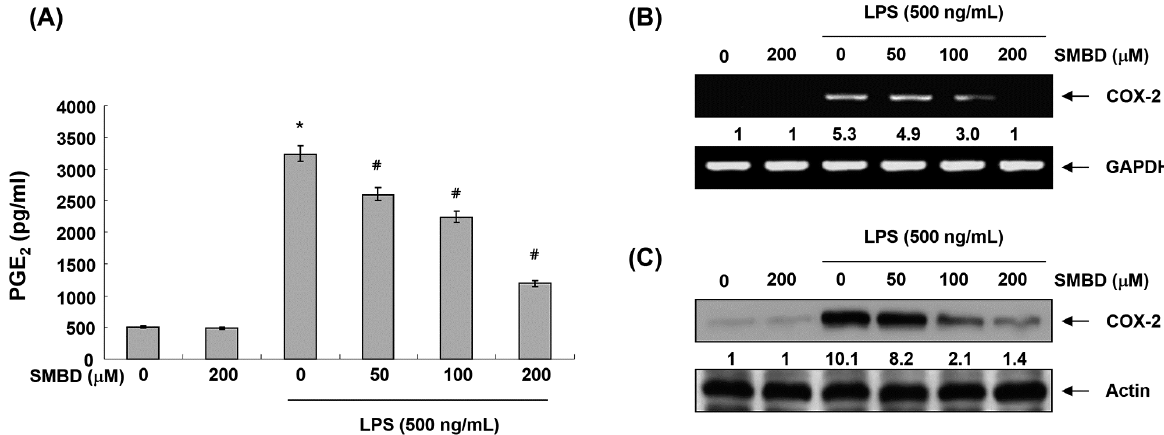
Figure 3. Effects of SMBD on LPS-induced PGE 2 production and COX-2 expression in BV2 microglia. Cells were treated with the indicated concentrations of SMBD for 1 h and then incubated in the presence of LPS for 24 h. ( A ) PGE 2 concentration was measured in culture media using a commercial ELISA kit. Data are presented as mean ± SEM, and are representative of triplicate experiments. * p < 0.05 compared to control (LPS-free); # p < 0.05 compared to cells cultured with LPS. The mRNA ( B ) and protein ( C ) levels of COX-2 were determined by RT-PCR and Western blot analysis, respectively. GAPDH and actin were used internal controls for the RT-PCR and Western blot assay, respectively. The numbers represent the average densitometric analyses as compared with GAPDH (B) and actin (C) in, at a minimum, two or three different